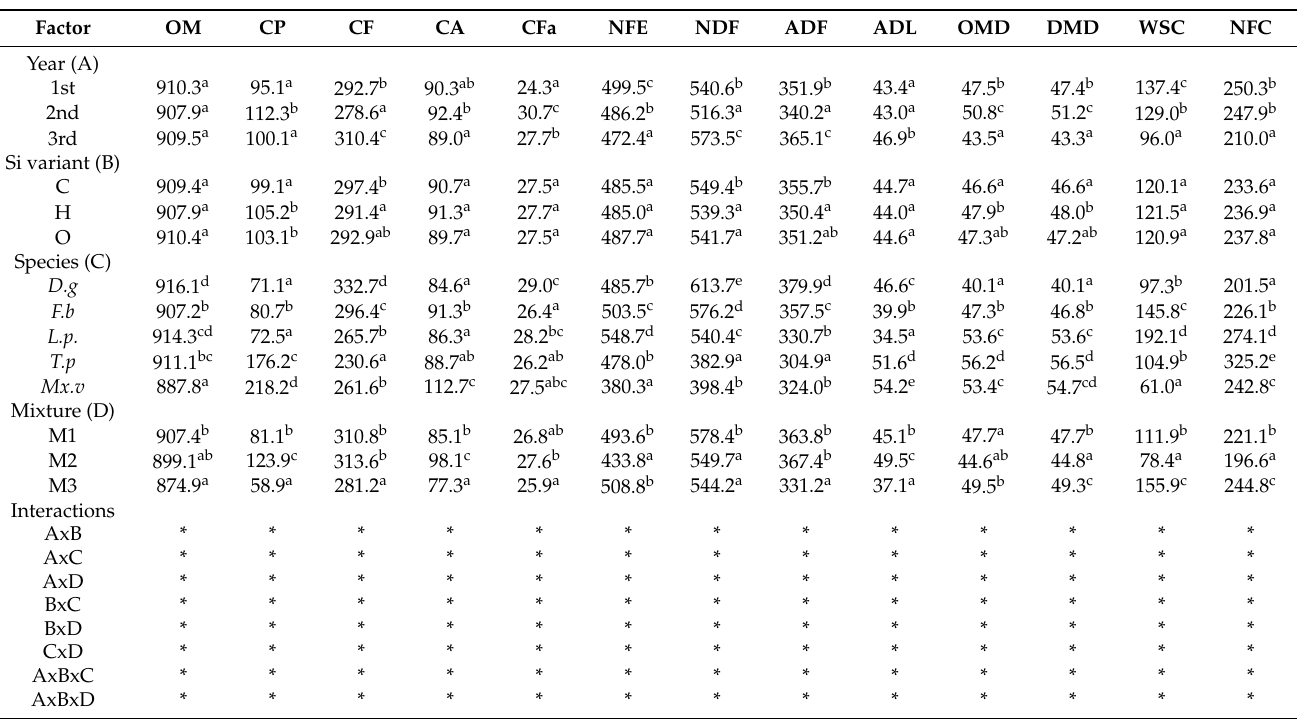
Table 2. The influence of silicon application on nutrients content (g/kg DM) and digestibility (%) of